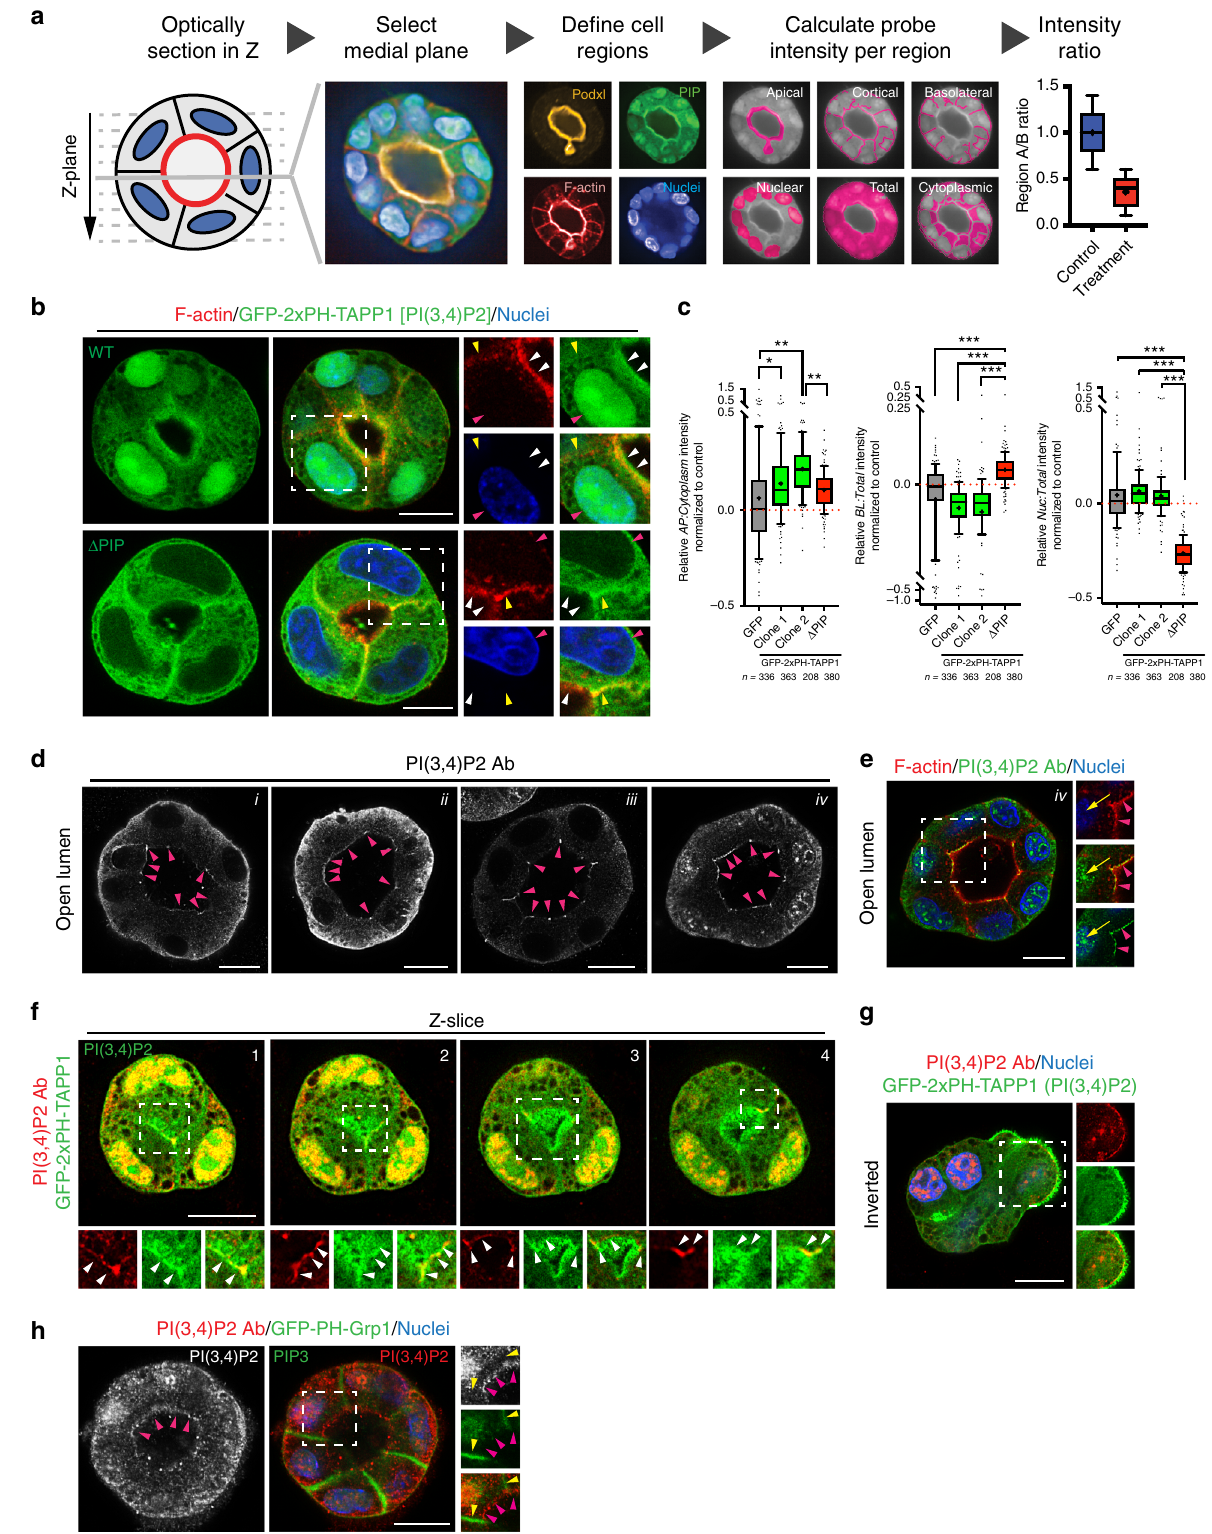
localized to a single punctum, occurring in the center of transcytosing Podxl vesicles, then juxtaposing the AMIS/PAP (Supplementary Fig. 3c, e, yellow and white arrowheads), before becoming localized to cilia and subapical puncta once lumens formed (Supplementary Fig. 3d). INPP5E